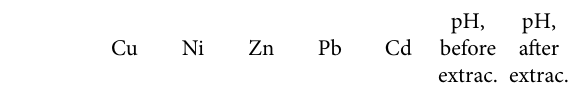
Table 4. Results obtained at the end of extraction with